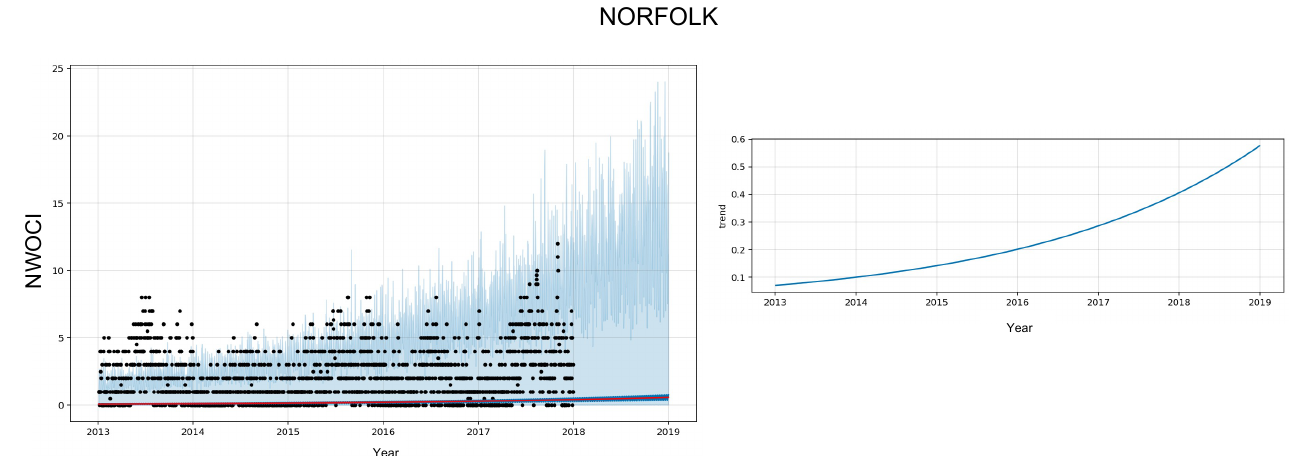
Figure A10. Left : One year forecast (2018 test data) from Prophet-BU Model for Norfolk county in MA. N.B: The solid blue line shows the average forecast while the solid red line shows the observed trend of NWOCI and the light blue region represents the 80% confidence interval for the forecast uncertainty. Also, the scatter points represent the historical values in the training data (2013–2017). Right : Corresponding trend decomposition from Prophet-BU Model.